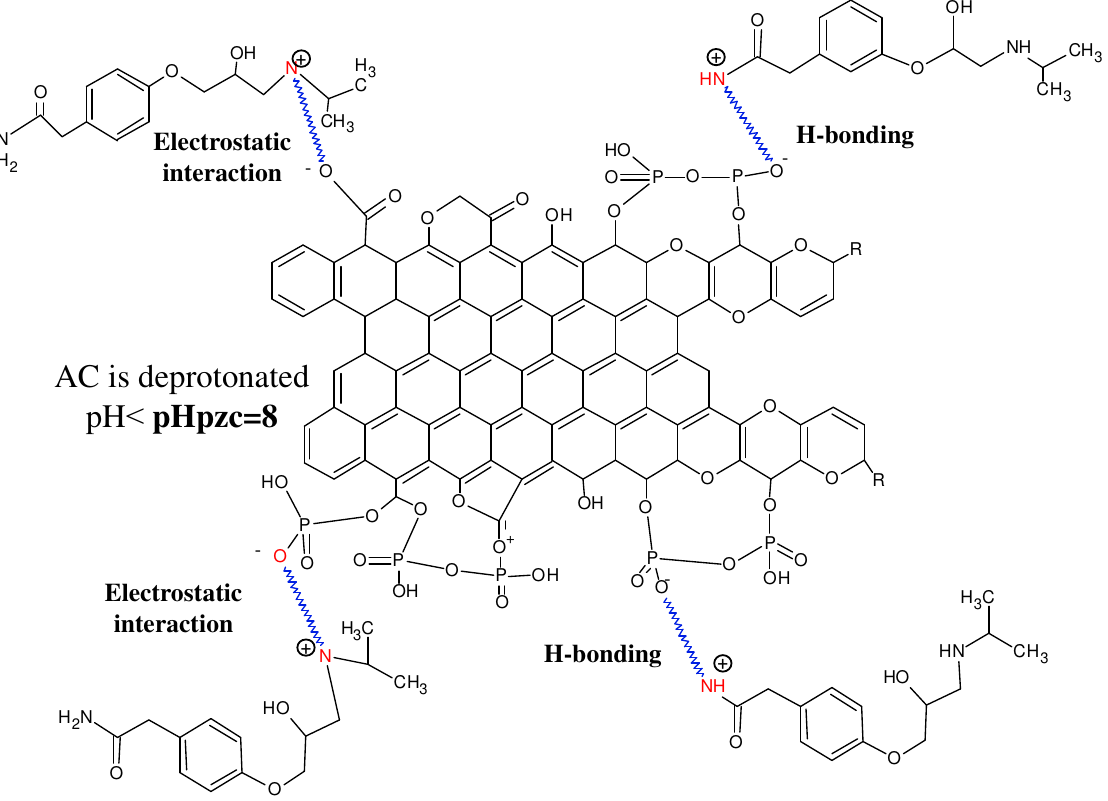
Table 6 compiles the fitting parameters for the kinetic studies using (Equations (5) and (6)). The R 2 larger than 0.99 as well as the calculated q max values close to the experimental ones indicated that atenolol uptake onto all adsorbents could be satisfactorily described by the pseudo-second-order model. This same tendency was observed in the adsorption of